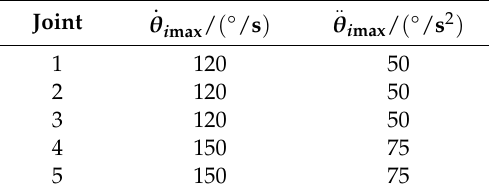
Table 1. Constraints on each